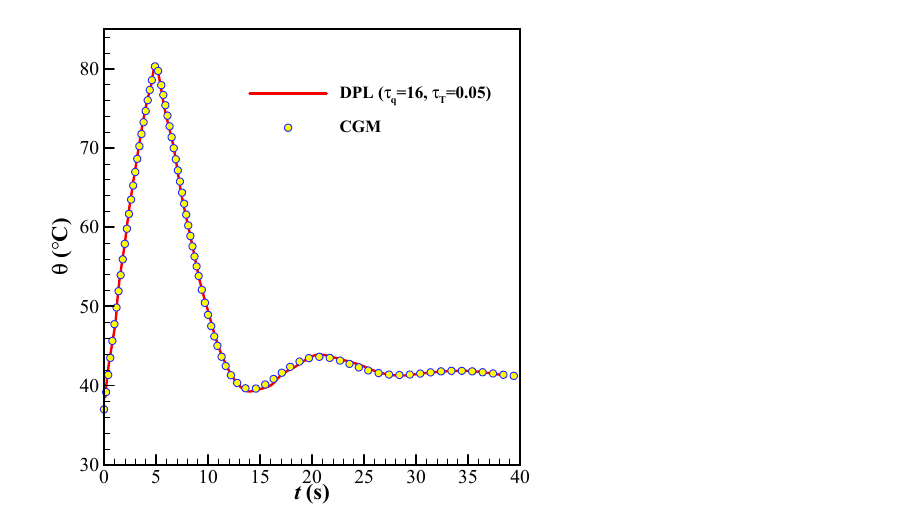
Figure 3. Comparison of the estimation temperature history from the FSPL model with the measured temperature from the DPL model for test case 1.